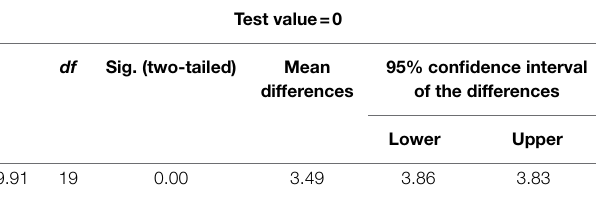
TABLE 9 | One-sample test of the flipped